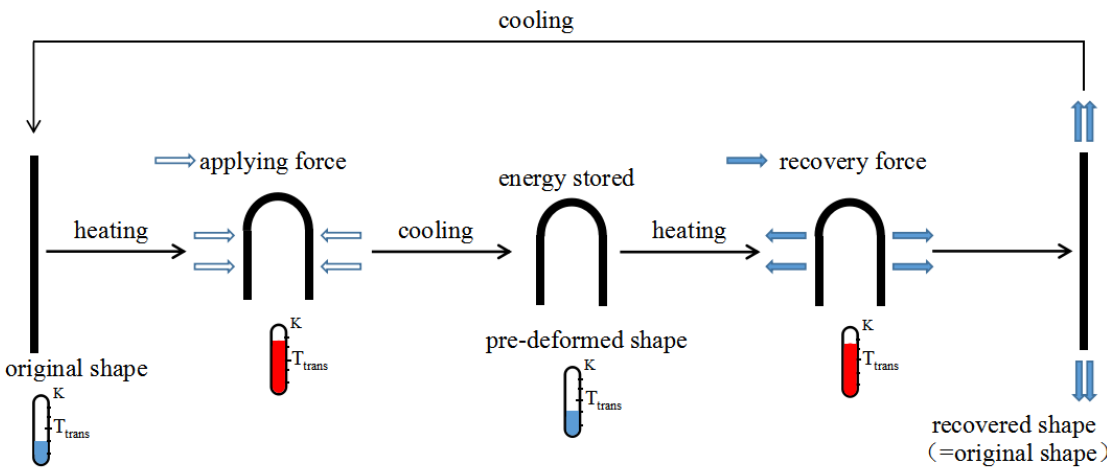
Figure 1. Schematic of thermomechanical deformation process of shape memory polymers (SMPs).